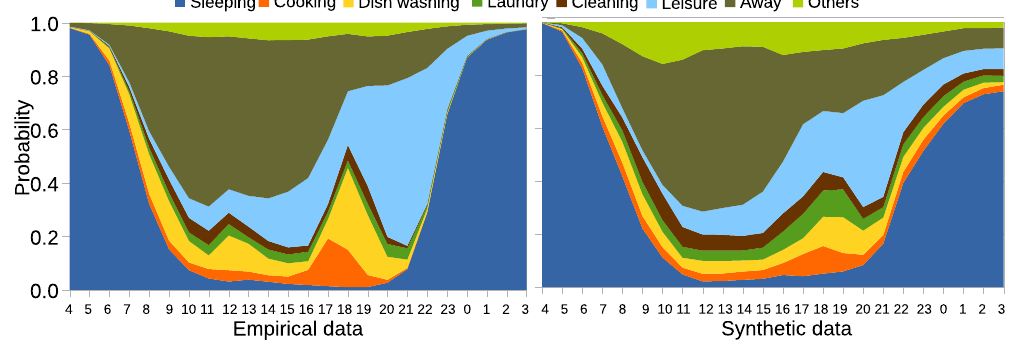
Figure 6. Comparison between the activity profiles.